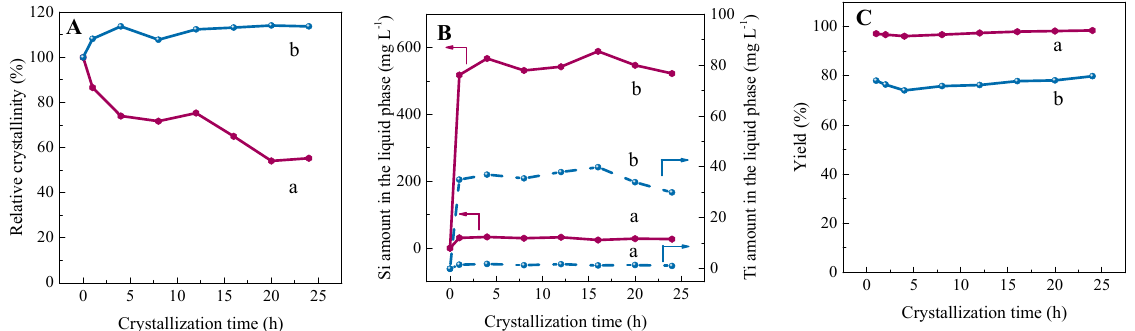
Figure 4. The variation of crystallinity ( A ), the Si (red line) and Ti (blue line) amounts ( B ) in the liquid phase, and the solid product yield ( C ) of Re − Ti − Beta − 0.04 (a) and Re − Ti − Beta − 0.20 (b) with the increase in crystallization time.